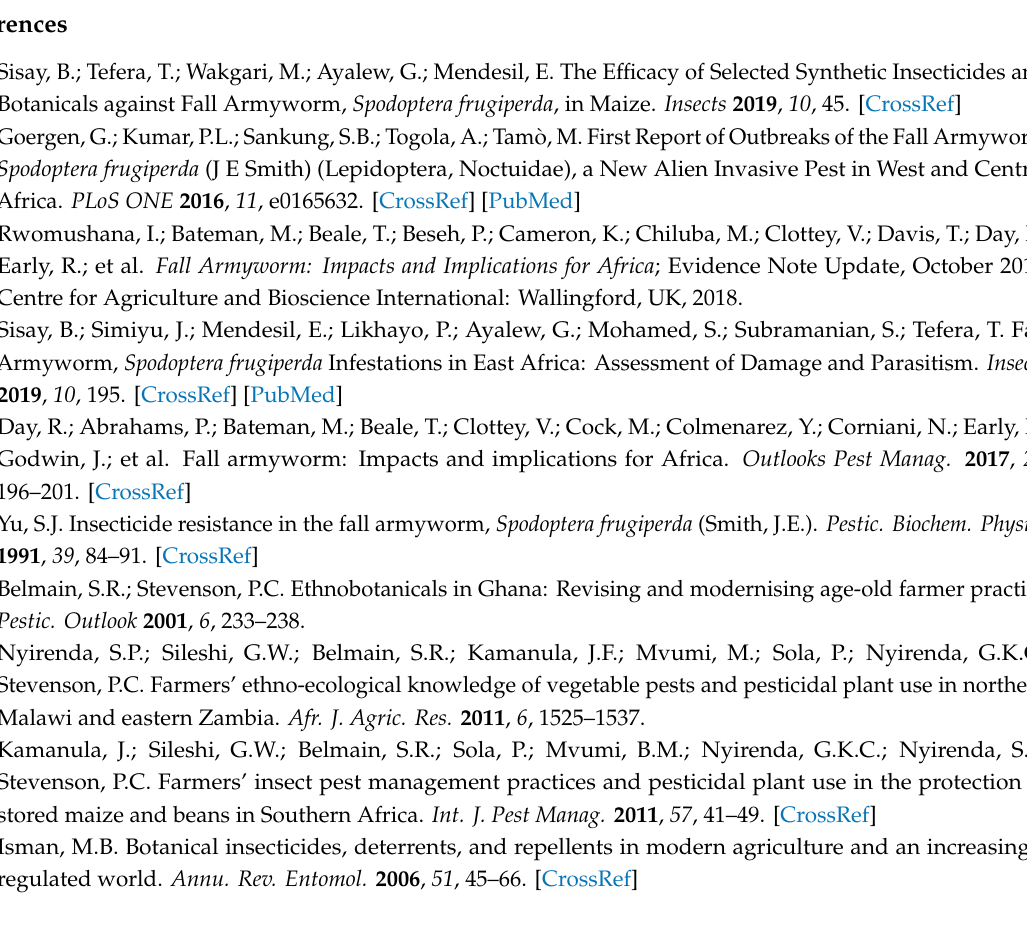
Table S1: Statistical analyses of fall armyworm bioassays evaluating pesticidal plants using two-way analysis of variance followed by Tukey’s HSD test to separate the means. Means followed by the same letter in an experiment are not significantly di ff erent from each